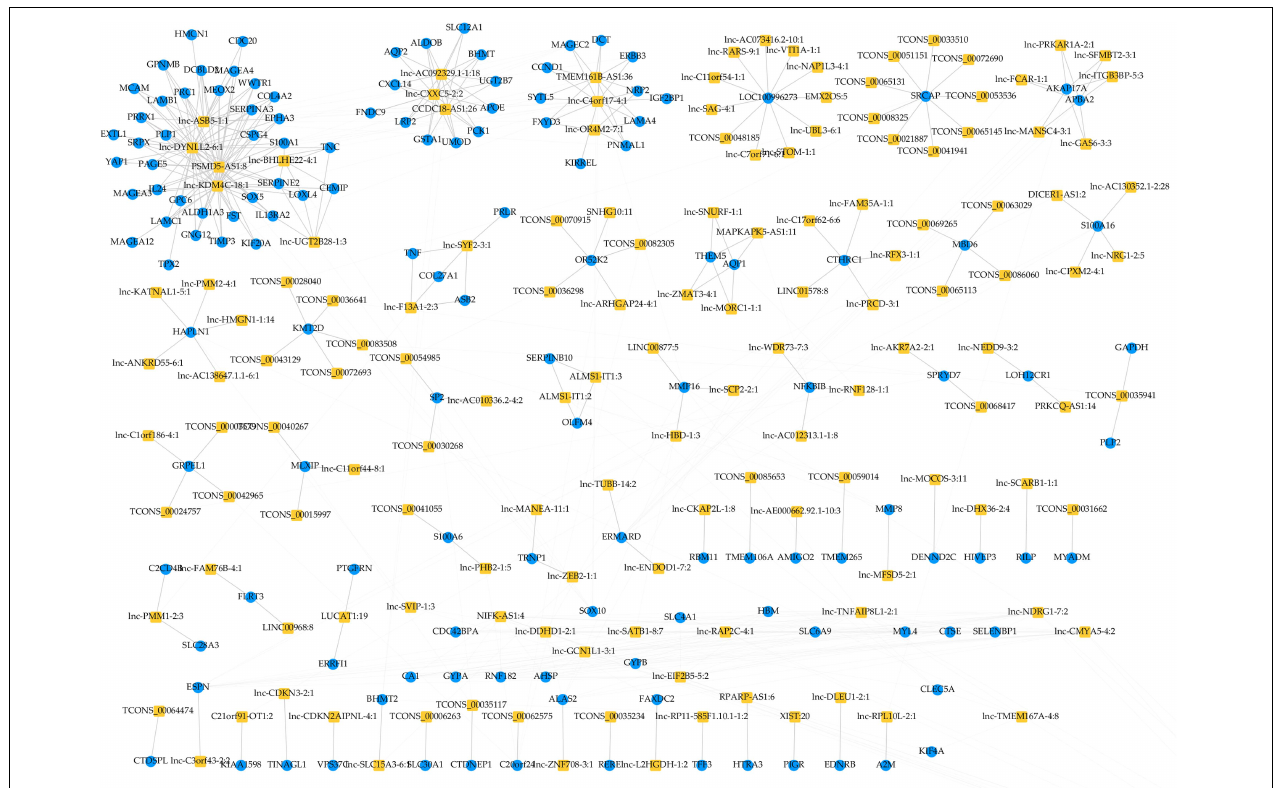
FIGURE 3 | MCL clustering of coexpression lncRNA and